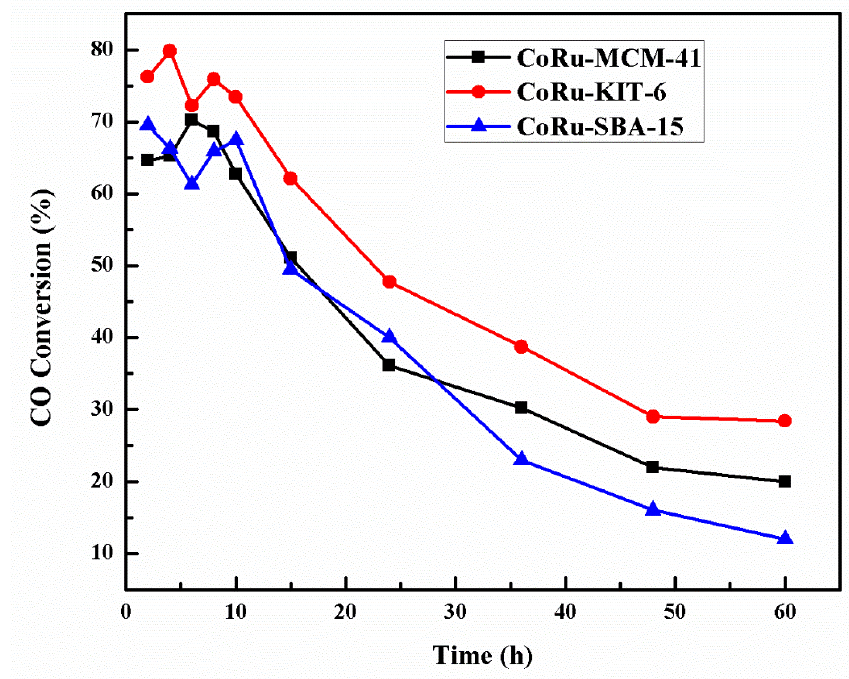
Figure 12. Deactivation studies of the catalysts at T = 240 °C, P = 1 atm and H 2 :CO = 2:1.